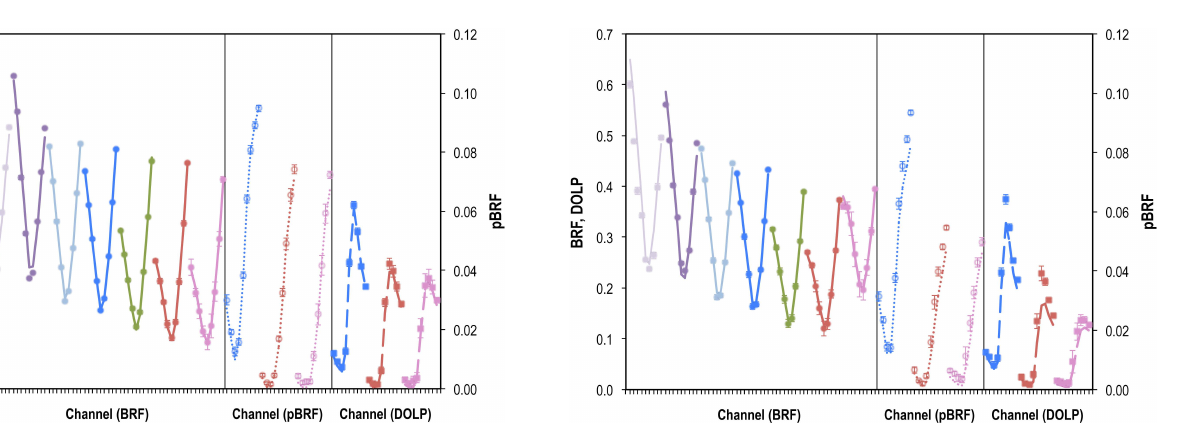
Fig. 14. Comparison of observed (circles) and modeled (lines) BRF in the 355, 380, 445, 470, 555, 660, and 865nm bands (first seven curves from left to right), pBRF (obs as open circles, mdl as dotted lines) in the 470, 660, and 865nm bands (next three curves), and DOLP at the same wavelengths (obs as squares, mdl as dashed lines) (last three curves) at the nine view angles acquired over the Fresno pond target. Within each of the spectral curves, view zenith angles from left to right are 67.7, 60.9, 50.2, 31.8, 3.1, 27.9, 46.8, 58.1, and 65.3 ◦ . The left-hand y axis is associated BRF and DOLP and the right-hand y axis is associated with pBRF. Error bars correspond to standard deviations of the data within the 100m × 100m target area.